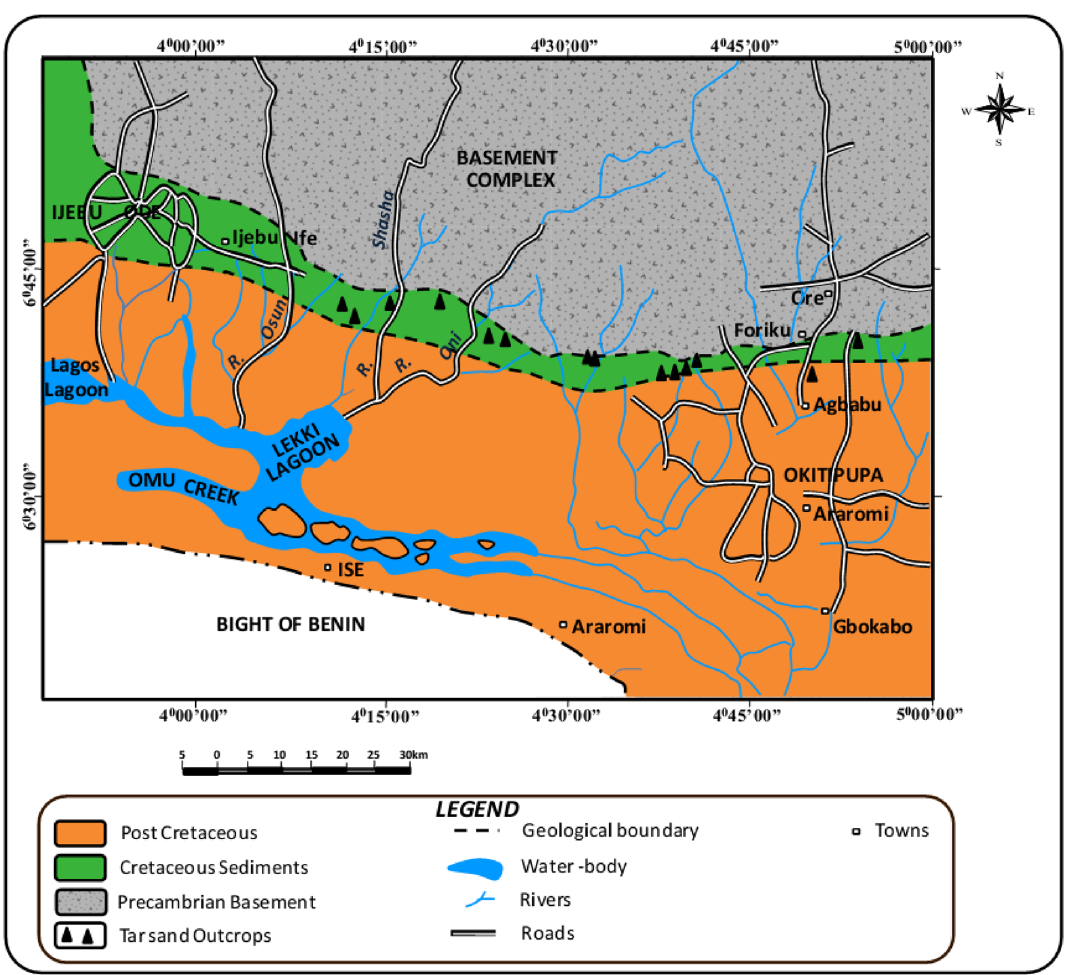
Fig. 1 Generalized geological map of the Eastern Dahomey Basin showing area extent of the tar sand deposits. Modified after Enu